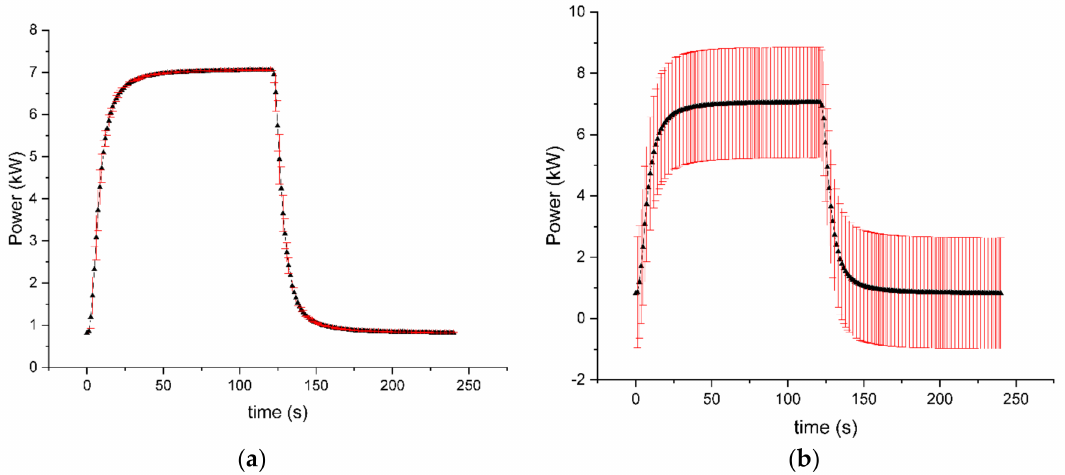
Figure 17. Power evolution for the run of 19 September 2019: ( a ) values averaged over 15 consecutive cycles with the associated standard deviation; ( b ) power evolution including the associated uncertainty.